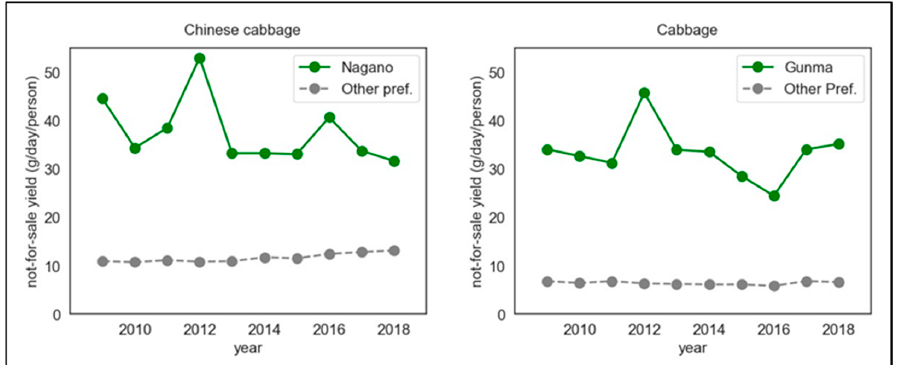
Figure 1. Trends of yield of not-for-sale Chinese cabbage and cabbage. Nagano: only Nagano Prefecture; Gunma: only Gunma Prefecture; Other pref.: for Chinese cabbage, mean of prefecture among Kanto 2 other than Nagano (i.e., Ibaraki, Tochigi, Gunma, and Yamanashi), and for cabbage,